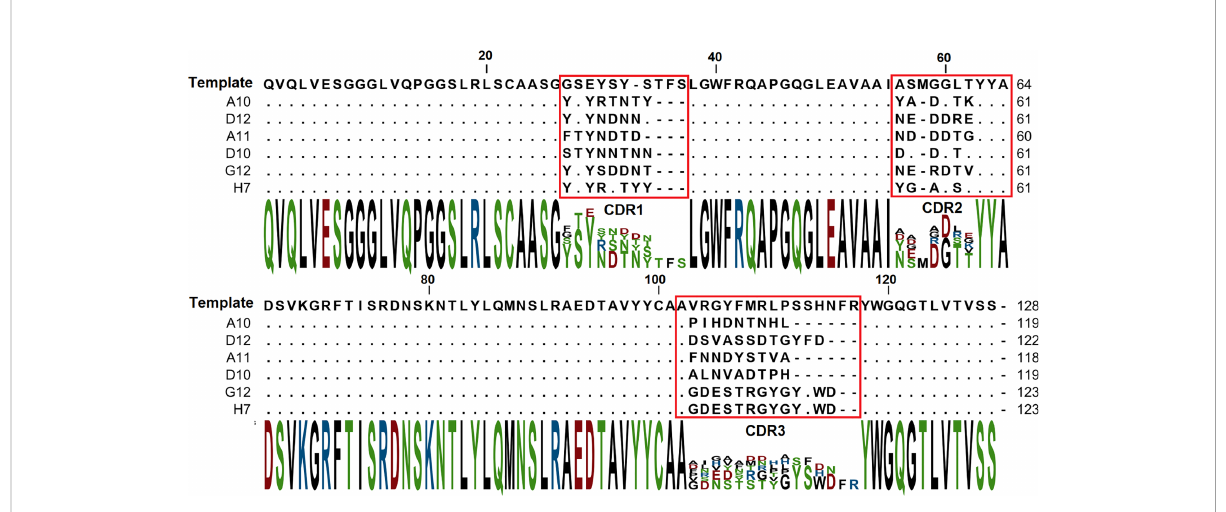
FIGURE 4 Amino acid sequences of selected VHH binders. CDR sequences are marked with red.